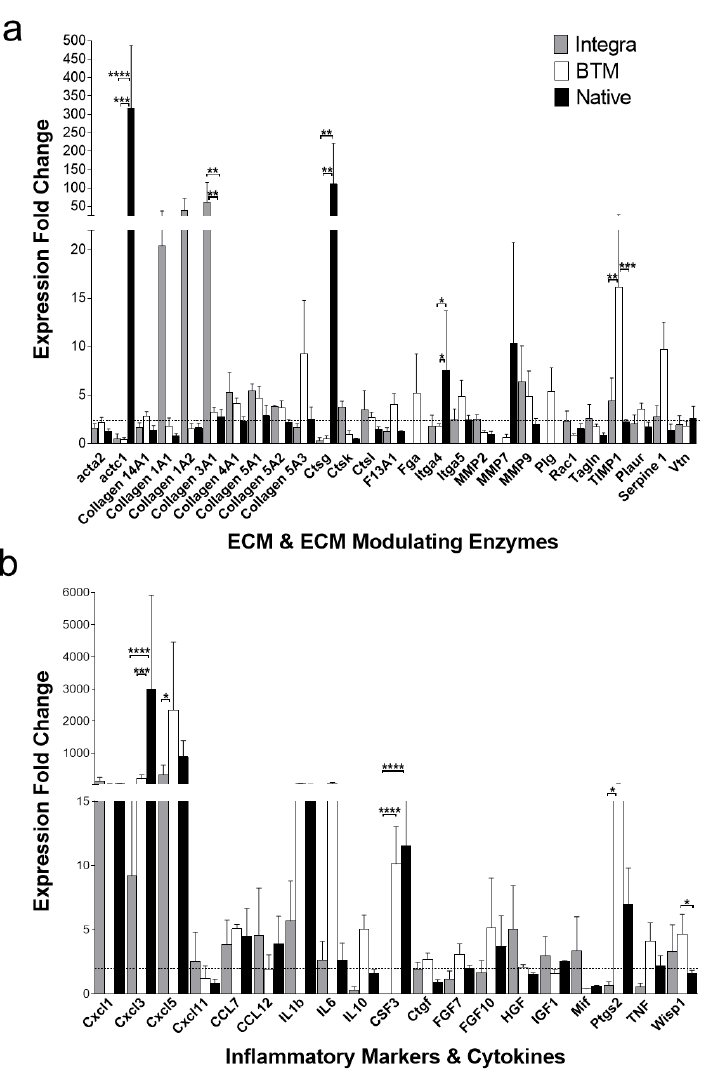
Figure 3. RNA expression profiling (mouse wound healing RT 2 profiler PCR array) of 2-week-long grafts. ( a ) Upregulated ECM structural and modifying enzyme genes identified in grafts by C t comparison with host RNA. ( b ) Upregulated inflammation markers, including cytokines and chemokines. Selected targets produced an average of >2-fold change in at least one of the studied groups. Mean and SEM values presented for each group ( n = 3 per group). * = p < 0.05, ** = p < 0.01, *** = p < 0.001, **** = p < 0.0001). A heatmap of all arrayed genes is available in Supplementary Data Figure